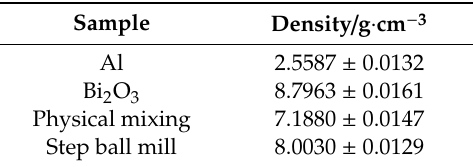
Table 3. Density of di ff erent